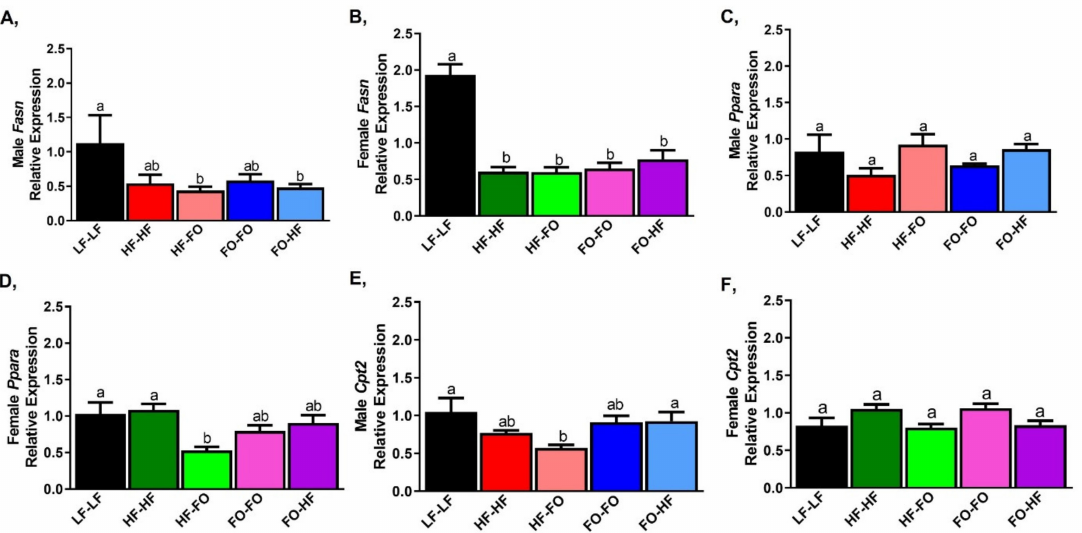
Figure 7. Fish oil alters markers of lipid metabolism in mice gonadal fat. ( A , B ) mRNA levels of fatty acid synthase ( Fasn ) in gonadal fat of male and female mice. ( C , D ) mRNA levels of fatty acid oxidation markers peroxisome proliferator activated receptor alpha ( Ppara ) in gonadal fat of male and female mice. ( E , F ) mRNA levels of carnityl palmitoyl transferase-2 ( Cpt2 ) in gonadal fat of male and female mice. Data is presented as mean ± SEM (n = 8 all groups). Common letters on the error bars indicate no significance (e.g., “a” is significantly different from “b” and “ab” indicates no significance compared to “a” and “b”).